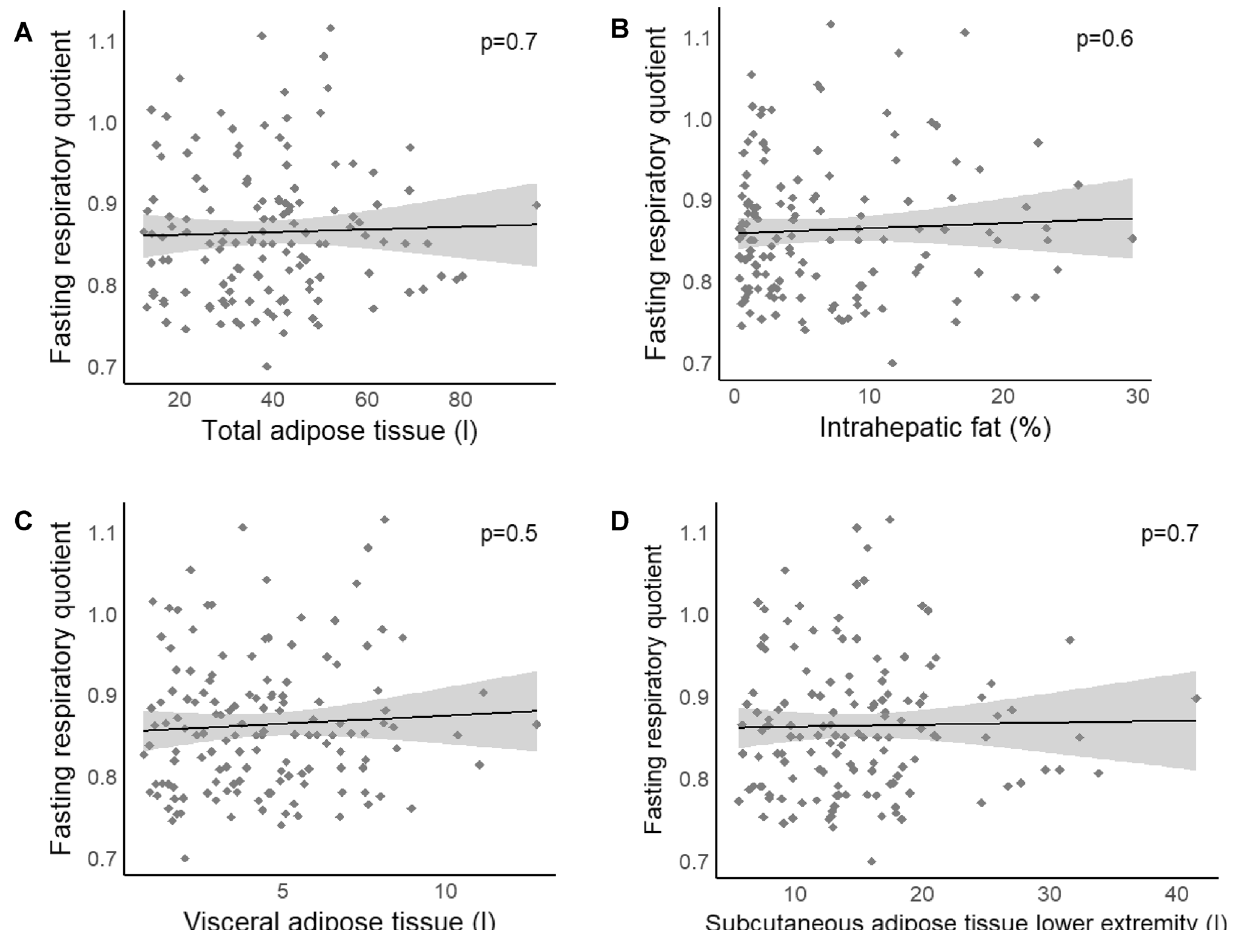
Figure 2. Association of respiratory quotient (RQ) and body fat distribution determined by whole-body MRI and liver MRS . Total adipose tissue ( A ), intrahepatic fat content ( B ), neither visceral nor subcutaneous adipose tissue ( C , D ) was correlated to RQ. Data are presented as scatterplots with linear regression lines and 95% CI. p values are derived from linear regression